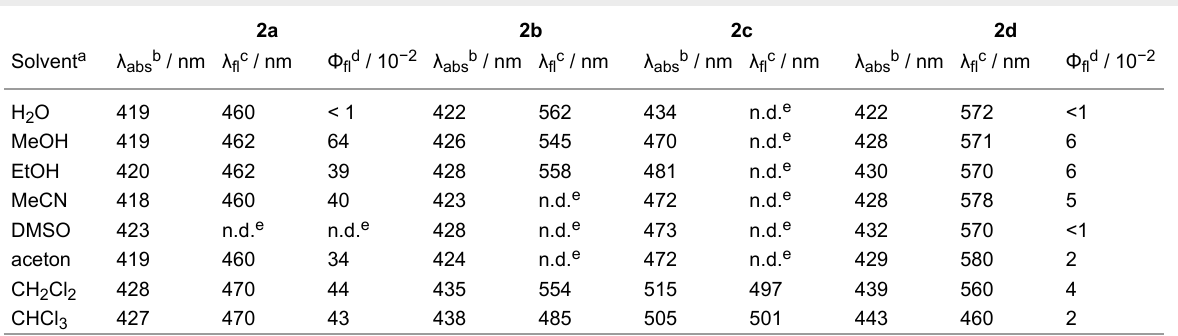
Table 2: Absorption and emission properties of benzo[ b ]quinolizinium derivatives 2a – d .